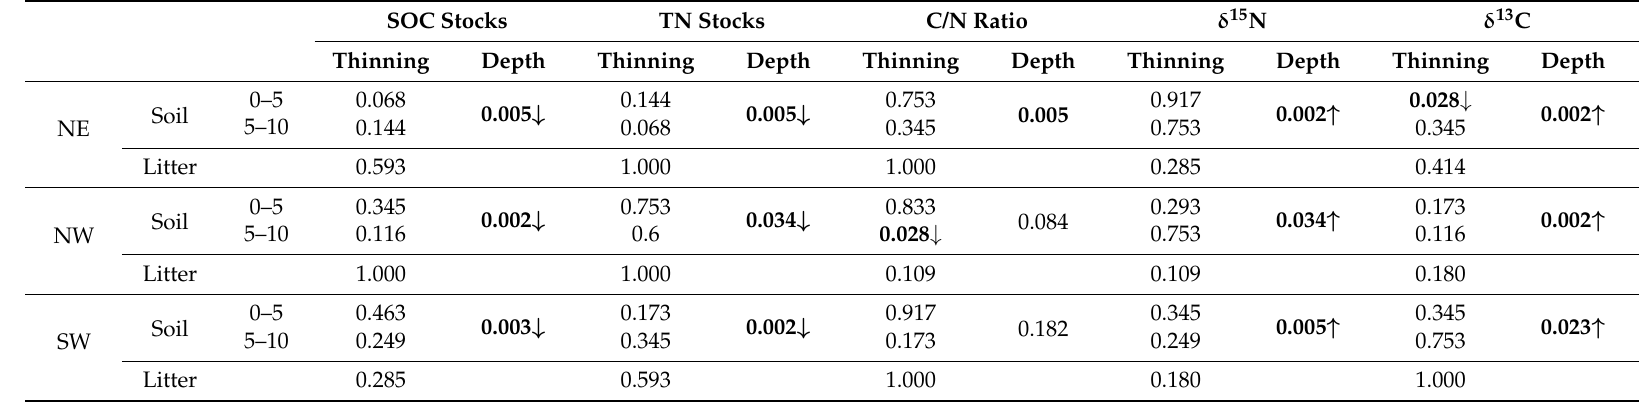
Table 3. p -values gained from the non-parametric Wilcoxon Signed Rank test to identify the effect of thinning and depth on SOC and TN stocks, C:N ratio, and δ 15 N and δ 13 C in different soil layers and site